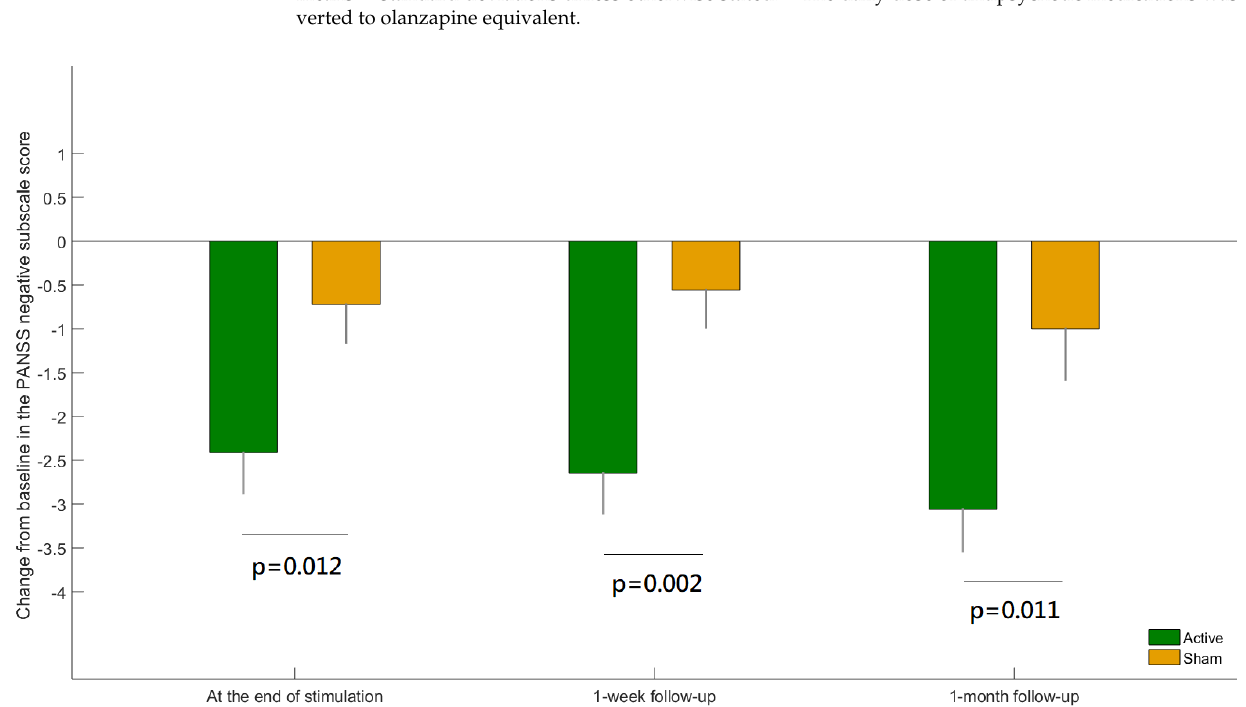
Figure 2. The difference between active versus sham group in the change from baseline for the Positive and Negative Syndrome Scale (PANSS) negative subscale score at each post-baseline visit. Error bars indicate standard errors of the means.